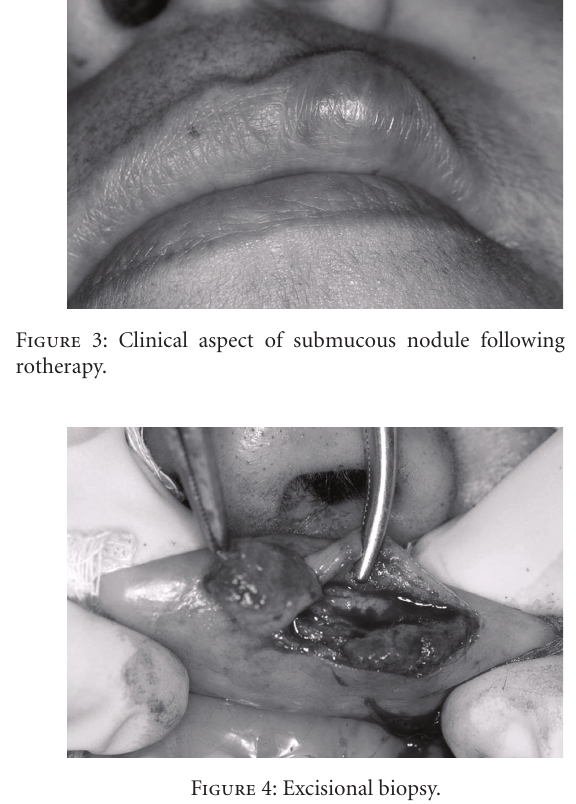
Figure 4: Excisional